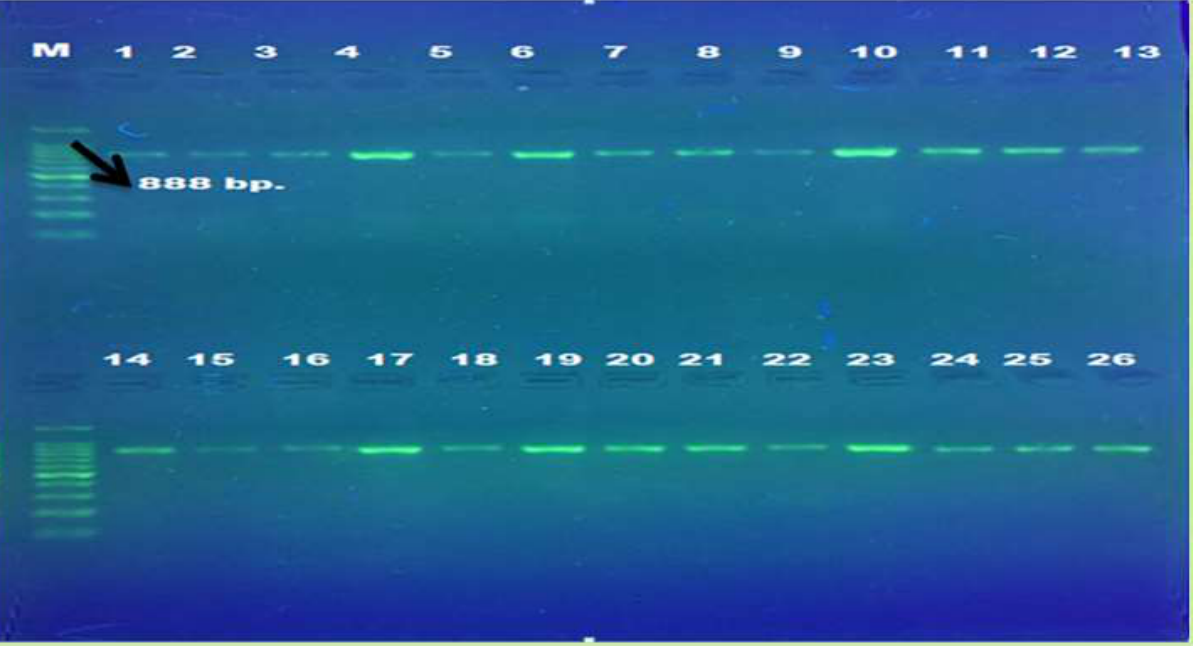
Figure 3: PCR product the band (888 bp) for (TCF7L2) gene. The product was electrophoresis in 1x TBE buffer for 1:30 hours on 2% agarose at 5 v/cm 2